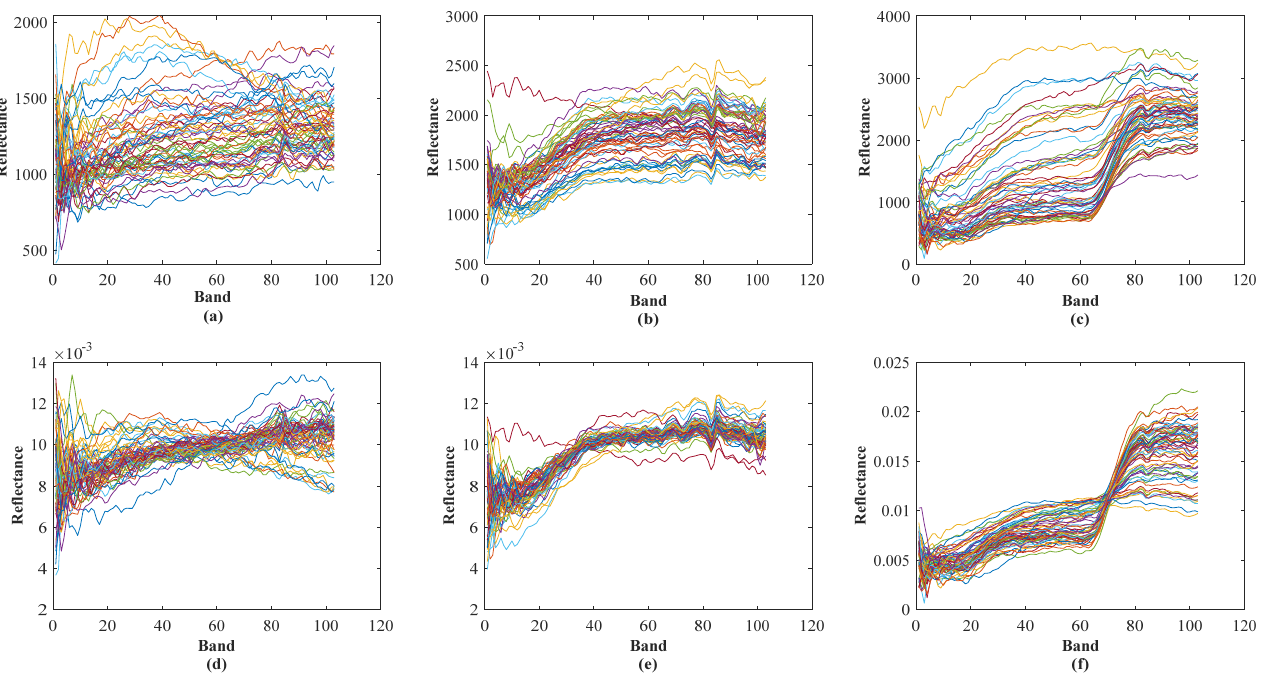
Figure 1. Original spectral response of ( a ) Asphalt , ( b ) Gravel , and ( c ) Bare Soil , and pretreated spectral response of ( d ) Asphalt , ( e ) Gravel , ( f ) Bare Soil with the AN method.